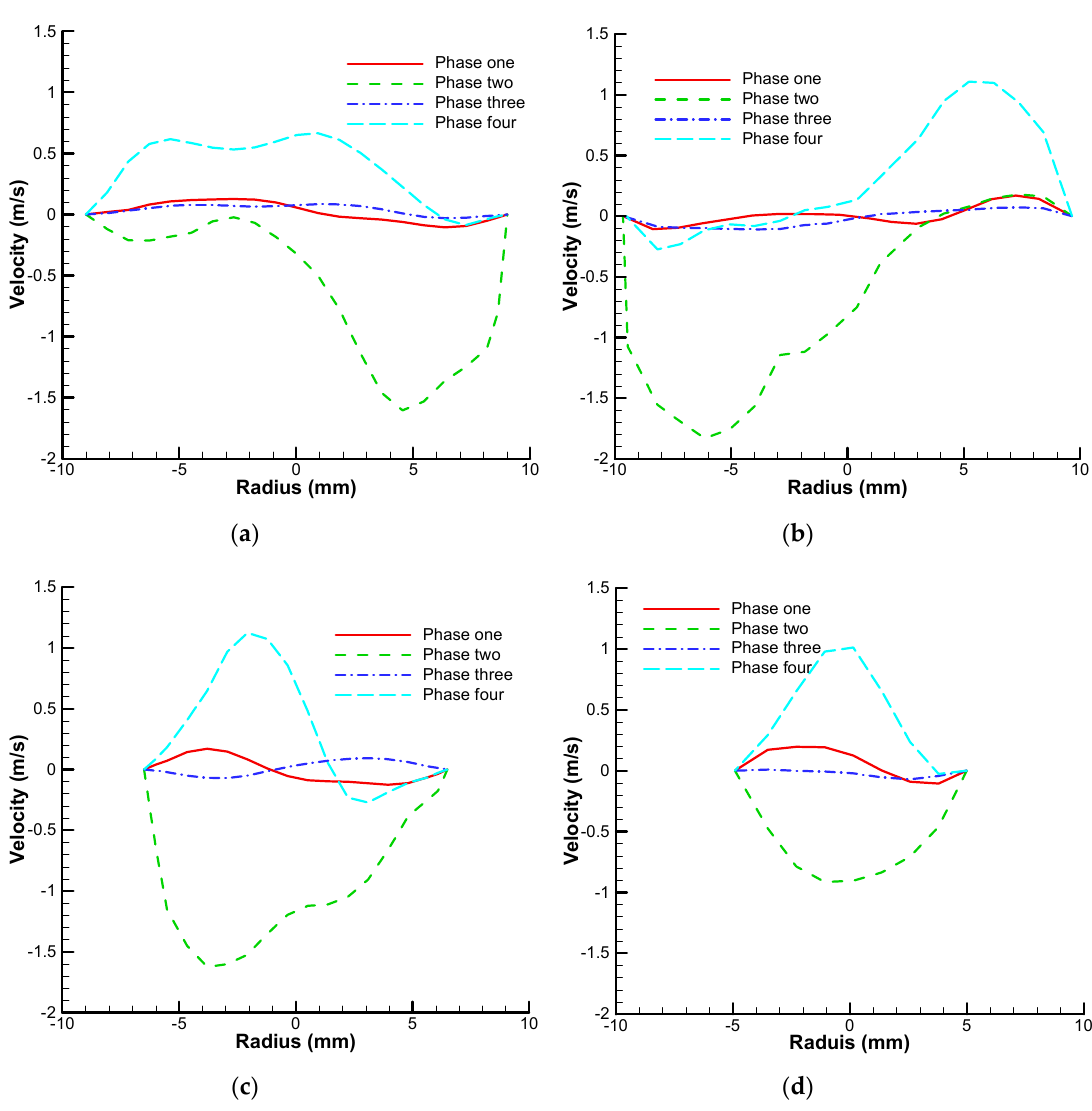
Figure 7. Measured main-stream velocities at four cross-sections at four representative phases: ( a ) cross-section 1; ( b ) cross-section 2; ( c ) cross-section 3; ( d ) cross-section 4. Locations of these four cross-sections are defined in Figure 2d.